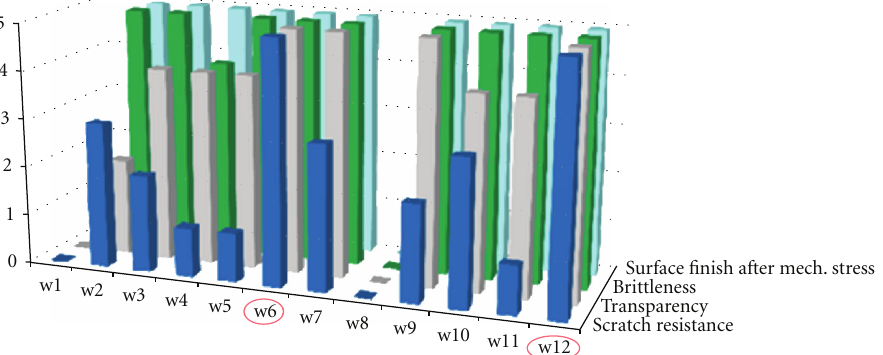
Figure 2: Mechanical and optical properties of di ff erent whey-based coating formulations screened according to a rating scale (0–5).